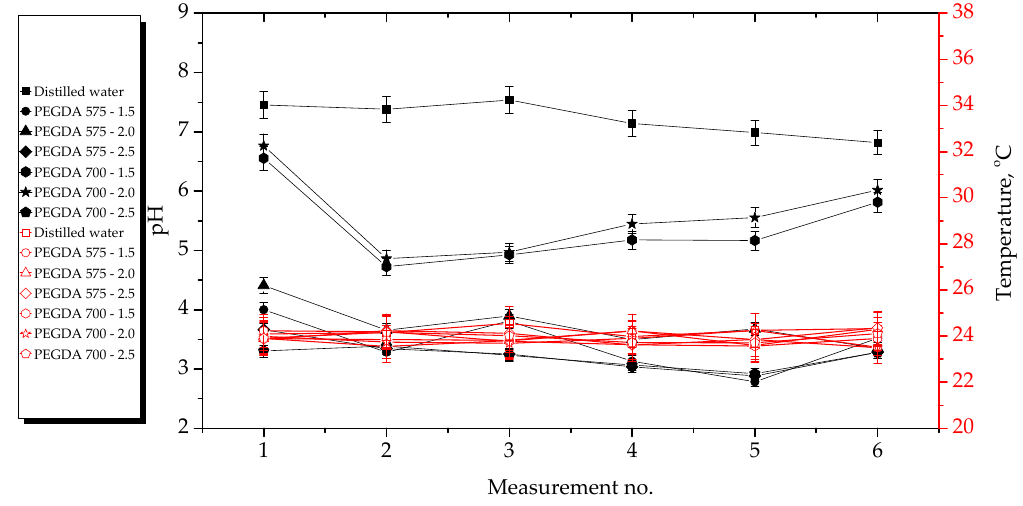
Figure 3. Results of hydrogel incubation in distilled water.